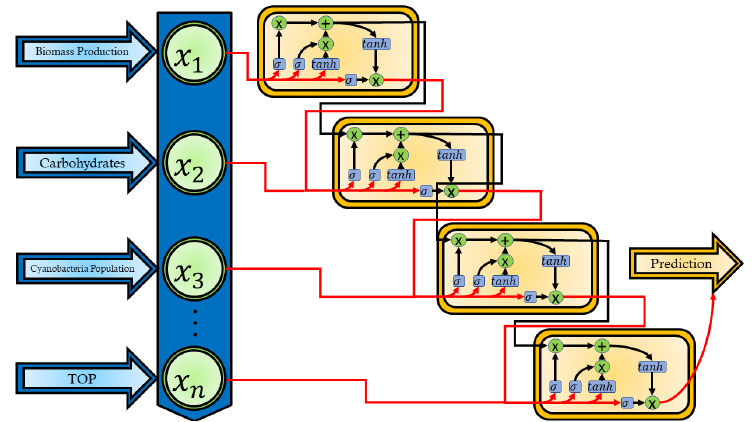
Figure 4. LSTM cell and connections for regression tasks.